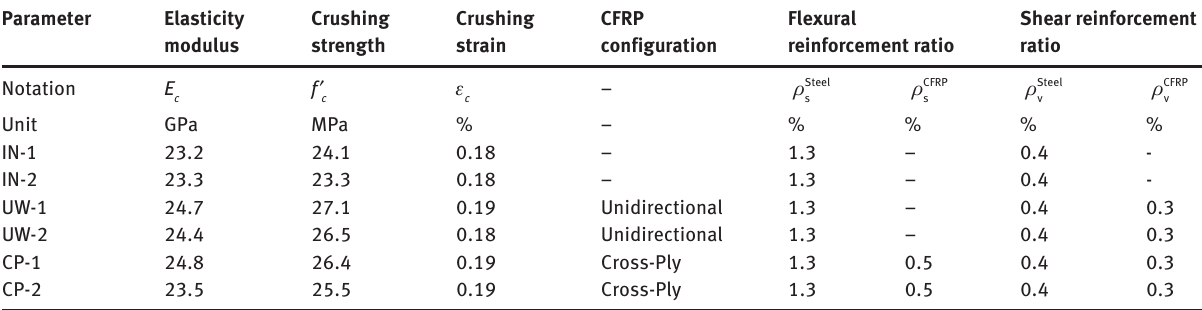
Table 1: Basic properties of constructed RC specimens Parameter Elasticity